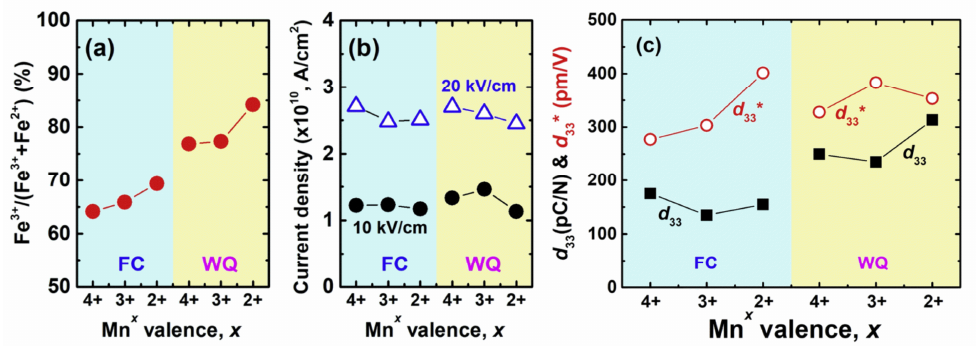
Figure 15. ( a ) Ratio of Fe 3+ , ( b ) Leakage current density, and ( c ) piezoelectric coefficients d 33 and d 33* of the 0.67Bi 1.05 (Fe 0.99 Mn x 0.01 )O 3 –0.33BaTiO 3 ( x = 4 + , 3 + , and 2 + ) ceramics. Reprinted with the permission of [130]. Copyright © 2019 Elsevier.